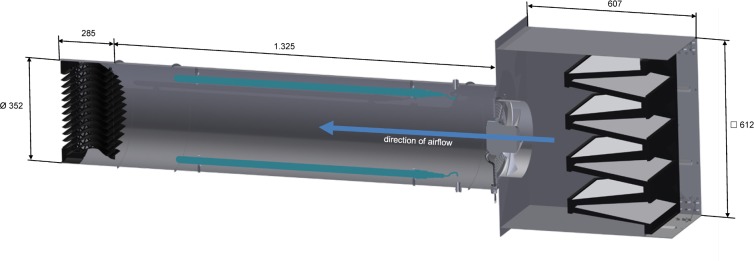
Longitudinal section of the UVC module.The module was composed of a pocket air filter (right rim of the picture), an axial fan (between filter and UVC tubes), and four UVC tubes (indicated as blue lines). A protective grid located downstream (left rim) ensured protection against UVC irradiation. The direction of airflow is given as blue arrow. UVC module dimensions are given in mm.